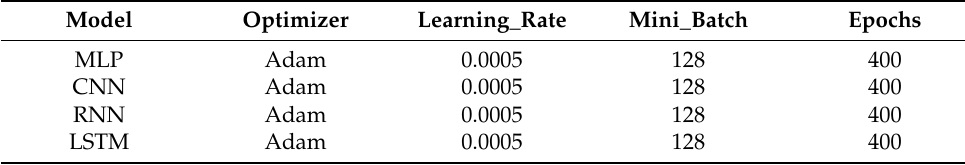
Table 1. Corresponding hyperparameter